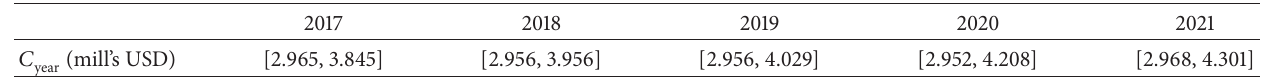
Table 6: Operating costs over production period 2017–2021.